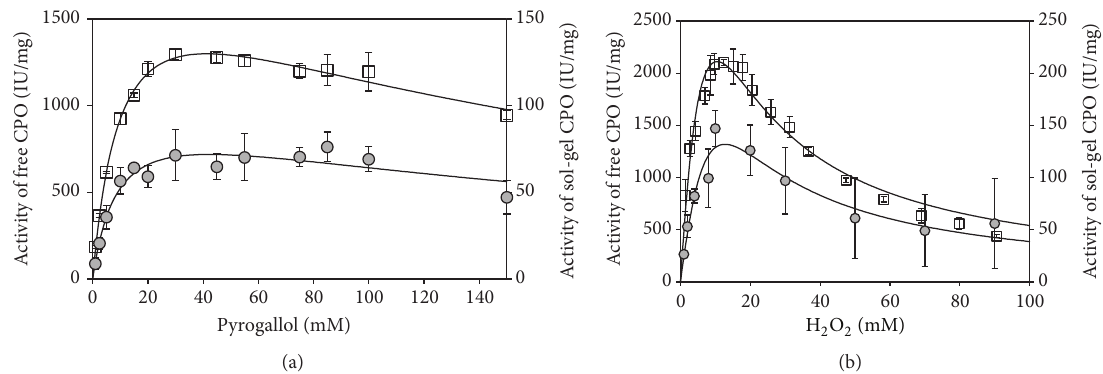
Figure 1: Peroxidation of pyrogallol catalyzed by free CPO (open squares; 0.575 𝜇 g CPO in 3mL total assay volume) and sol-gel entrapped CPO (grey circles; 0.575 𝜇 g CPO entrapped in three sol-gel beads placed in 3 mL total assay volume). The CPO sol-gel beads were prepared from TMOS with a pH 6.0 casting buffer and matured for one week with a buffer exchange on every other day. The activity assays were performed in 0.1 M citric acid-0.2 M dibasic sodium phosphate buffer, pH 4.2 with constant concentrations of either 2.7 mM H 2 O 2 (a) or 35 mM pyrogallol (b). All data were measured in triplicate and are displayed as mean values ± one standard deviation. The parameters of the curve fits are summarized in Table 1. Table 1: Enzyme kinetic parameters for the CPO catalyzed peroxidation of pyrogallol ∗ . 𝐾 𝑀 (mM)